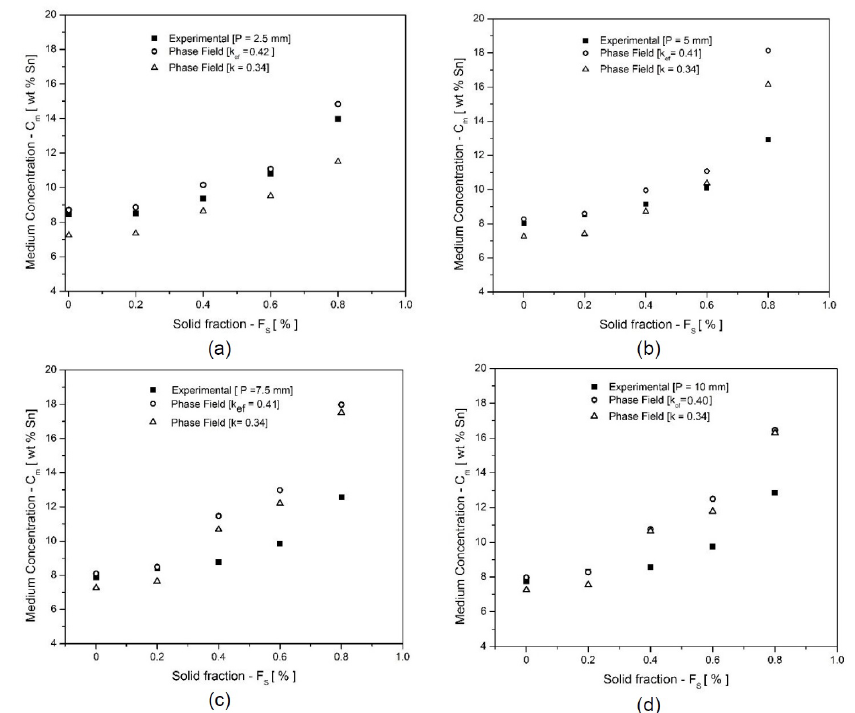
and k at different ef eq